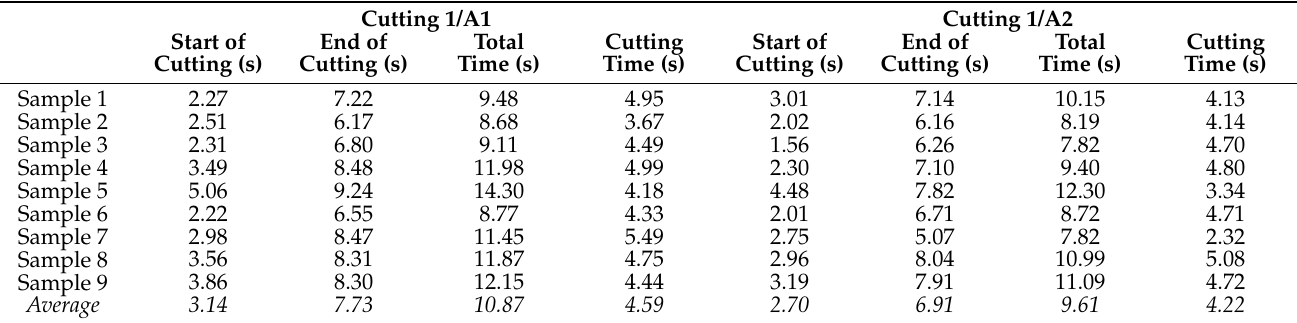
Table 3. Experiment results—cutting process time parameters (“A” pillars, 9 samples, 2 measurements